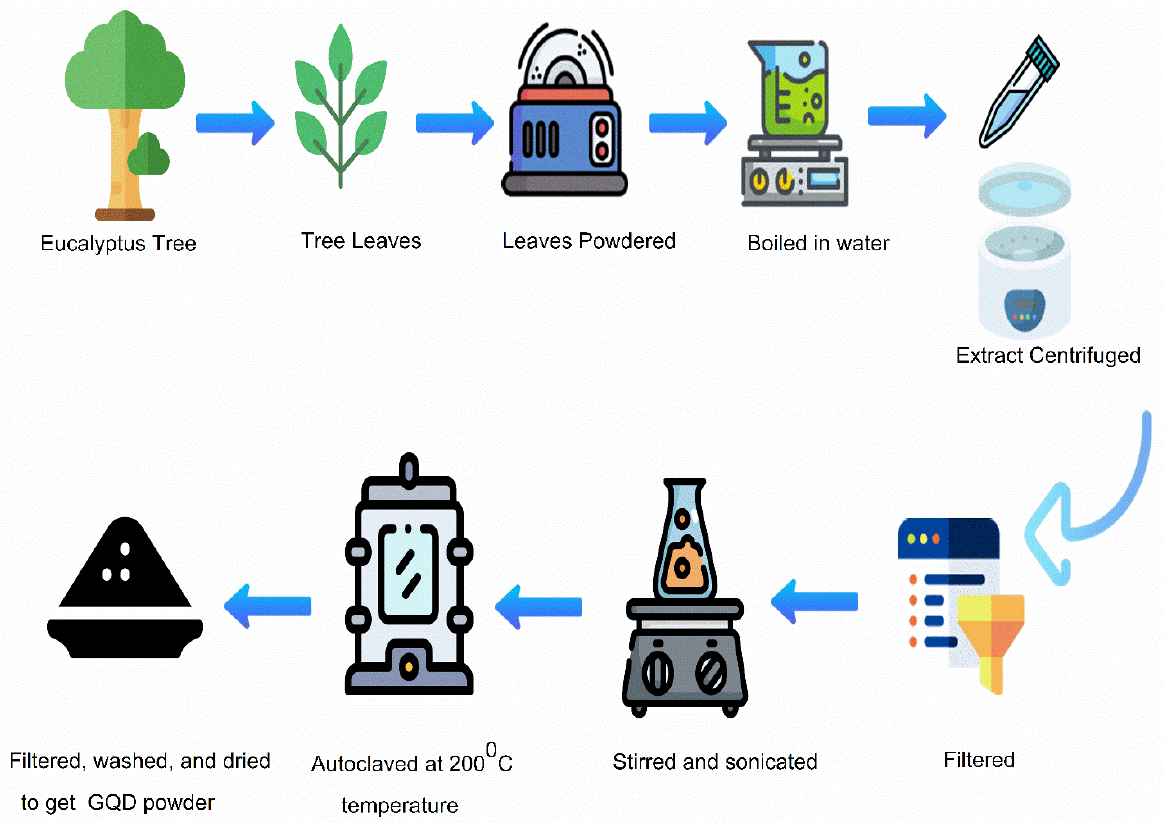
Figure 2. Schematic illustration of the preparation of GQDs from eucalyptus tree leaves.